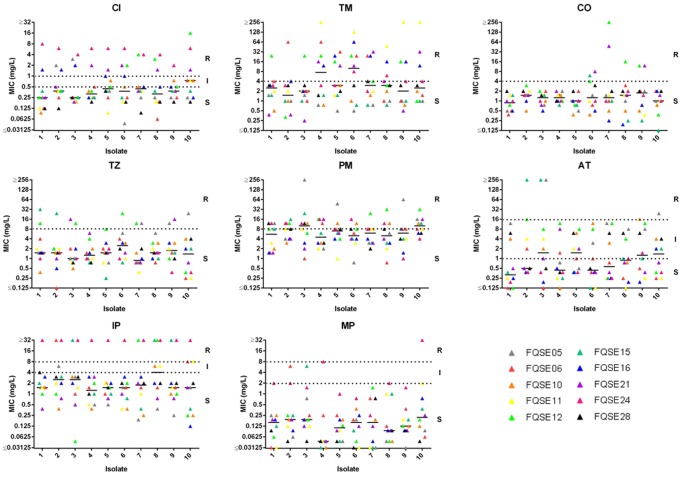
Evolution of minimal inhibitory concentrations (MICs) from the first to the last studied isolate from each patient.Each color represents a different patient. CI, ciprofloxacin; TM, tobramycin; CO, colistin; TZ, ceftazidime; PM, cefepime; AT, aztreonam; IP, impenem; MP, meropenem.